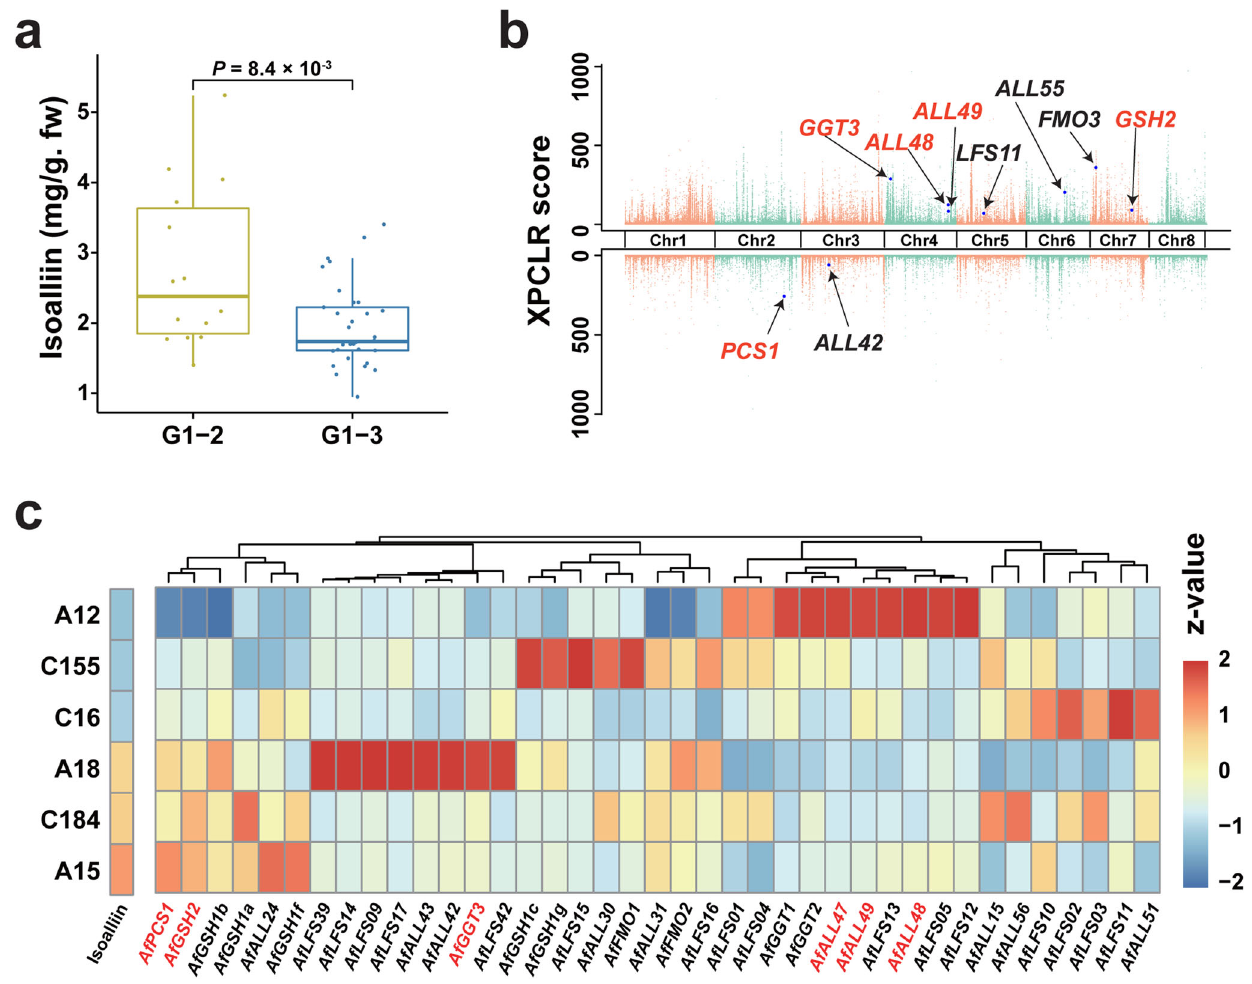
Fig. 7 | Insightsintothevariationofisoalliinaccumulationsin bunching onion accessions. a Isoalliin contents in leaves of G1-2 ( n =14) and G1-3 ( n =33). P- values were calculated using the two-tailed Wilcoxon test. In the box plots, the minima, maxima, center bounds of box showed 25%, 75% quartile values and the average values, while the whiskersshowed maximaand minimavalues of isoalliin contents. b Top: Genome-wide distribution of selective sweeps in G1-2 compared with